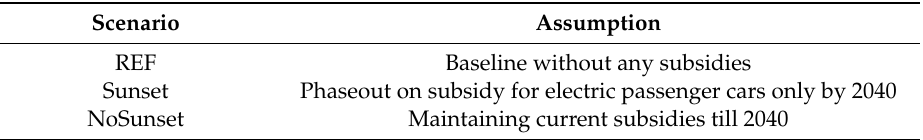
Table 3. Description of